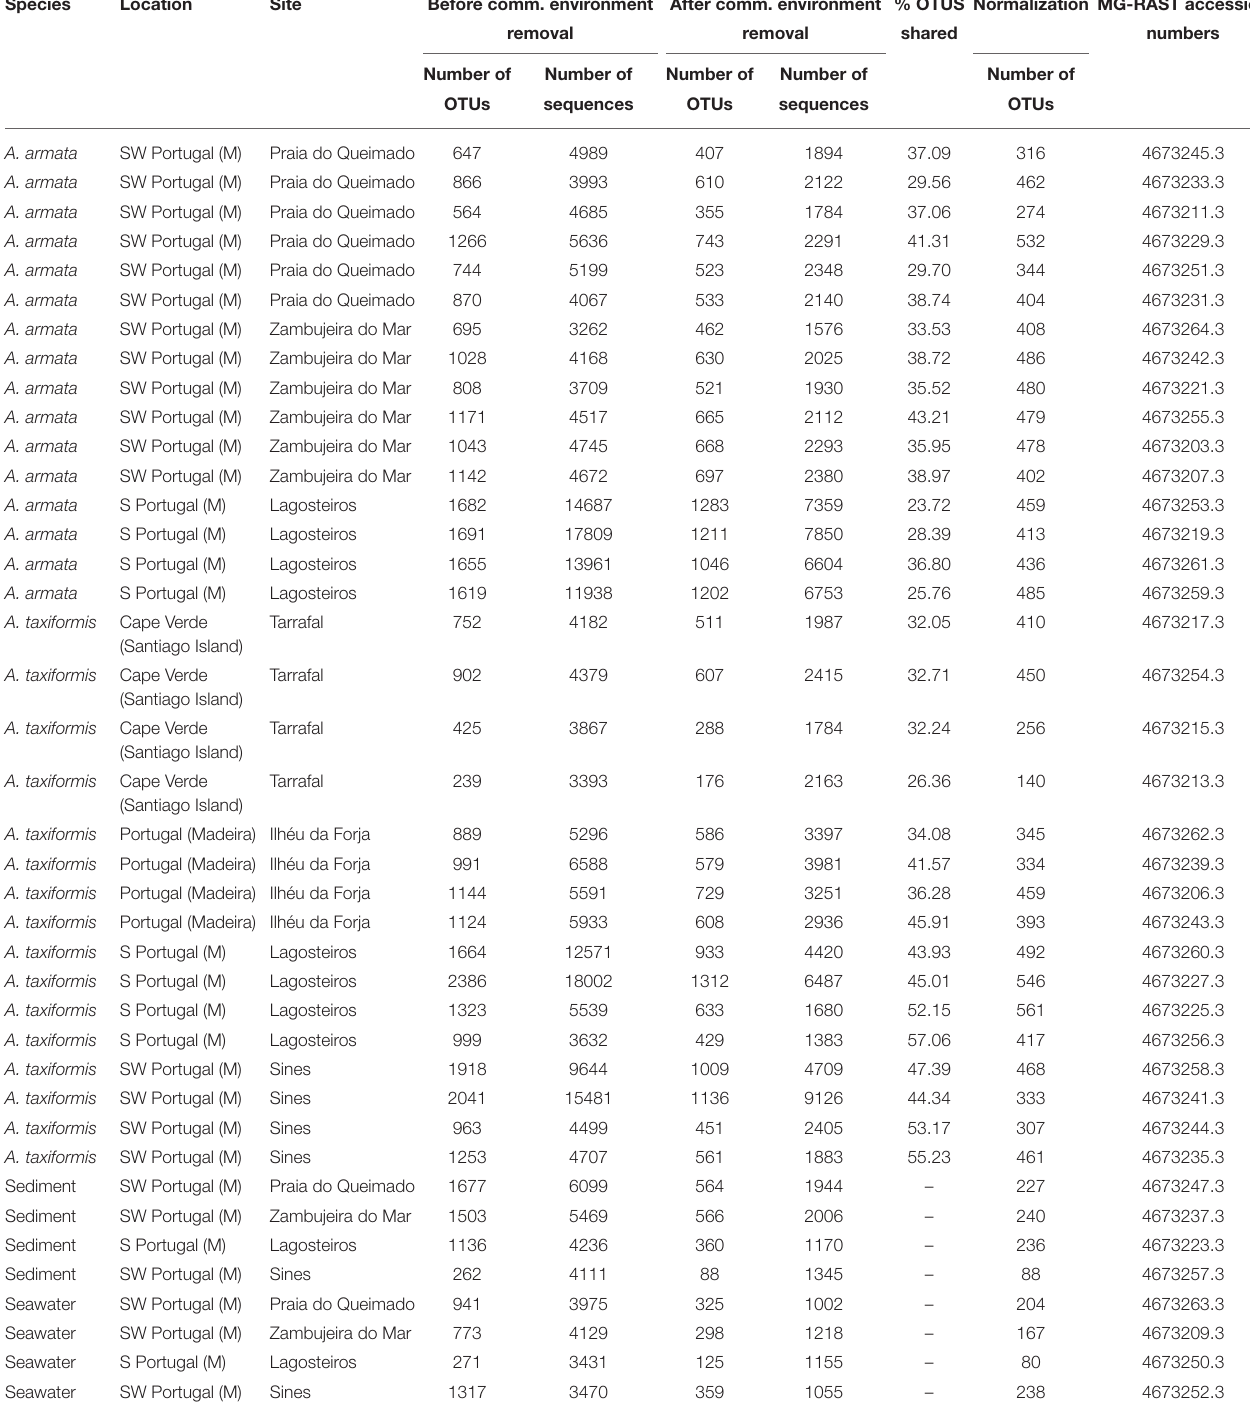
TABLE 1 | Number of OTUs and sequences of each replicate after quality control and removal of chimeras, chloroplast, unassigned sequences, and singletons.